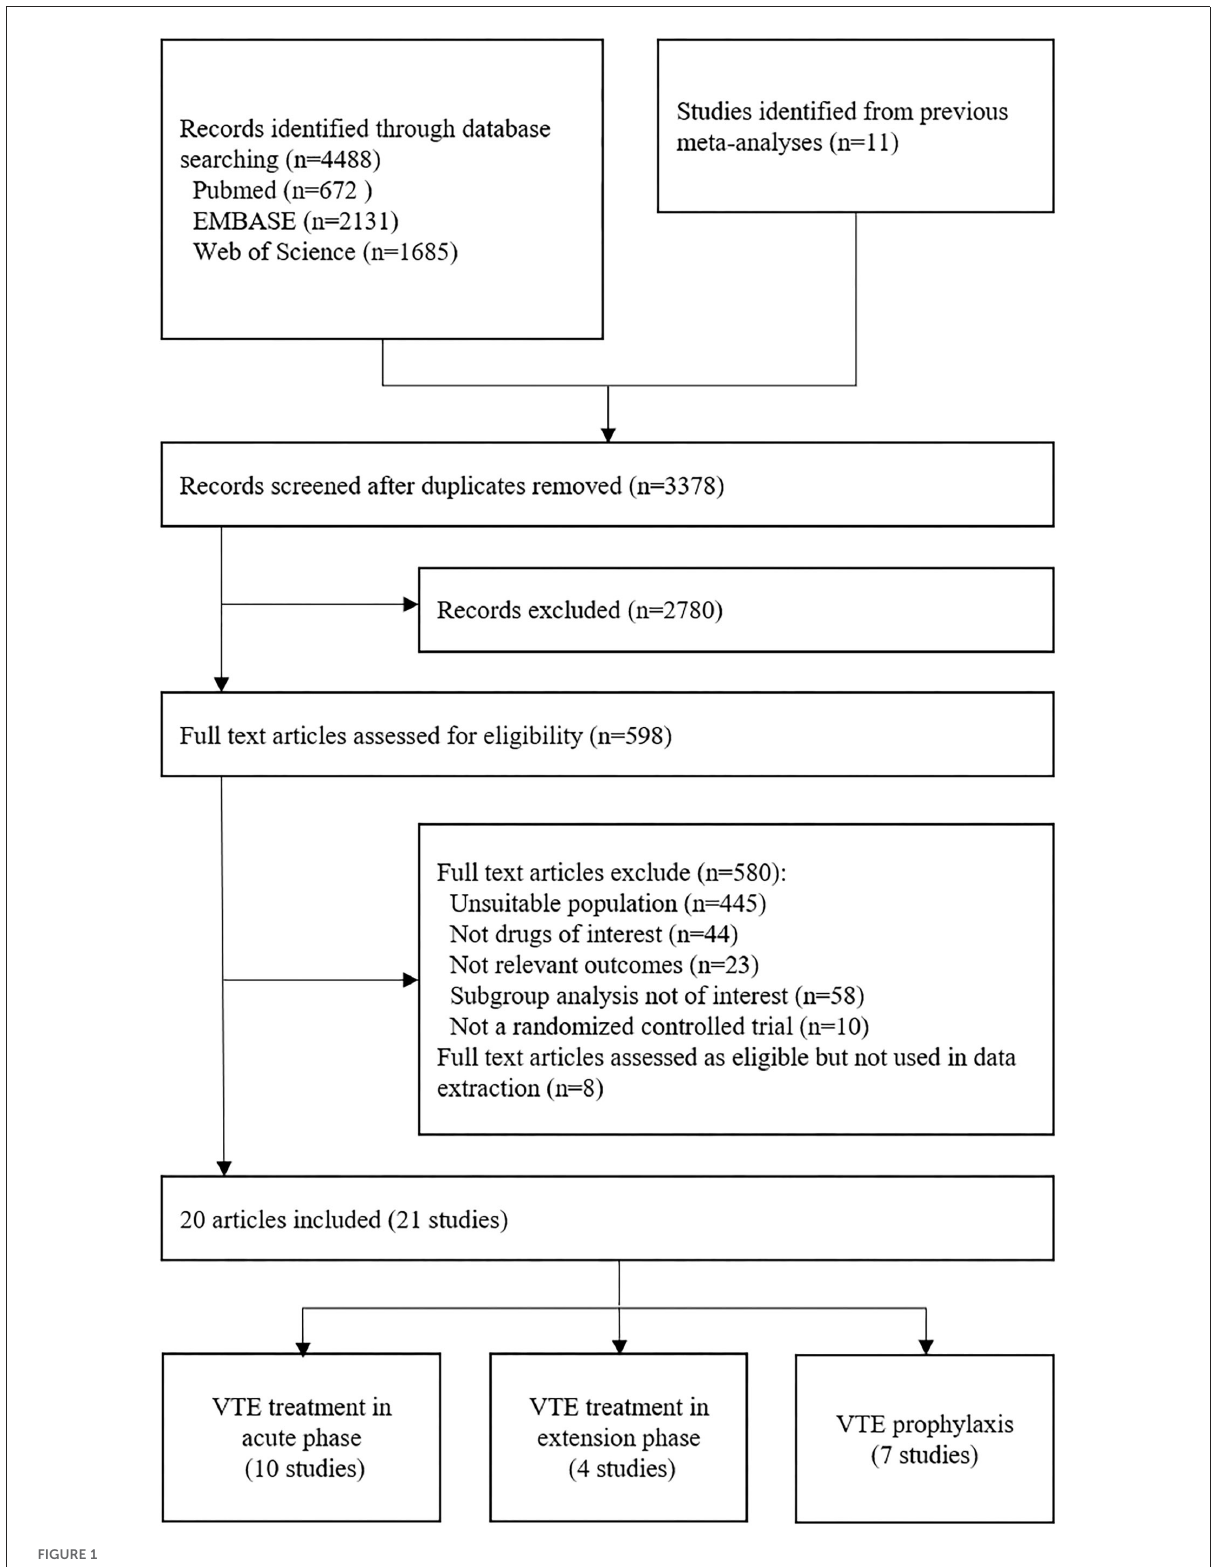
FIGURE1 Flow diagram of the selection of involved